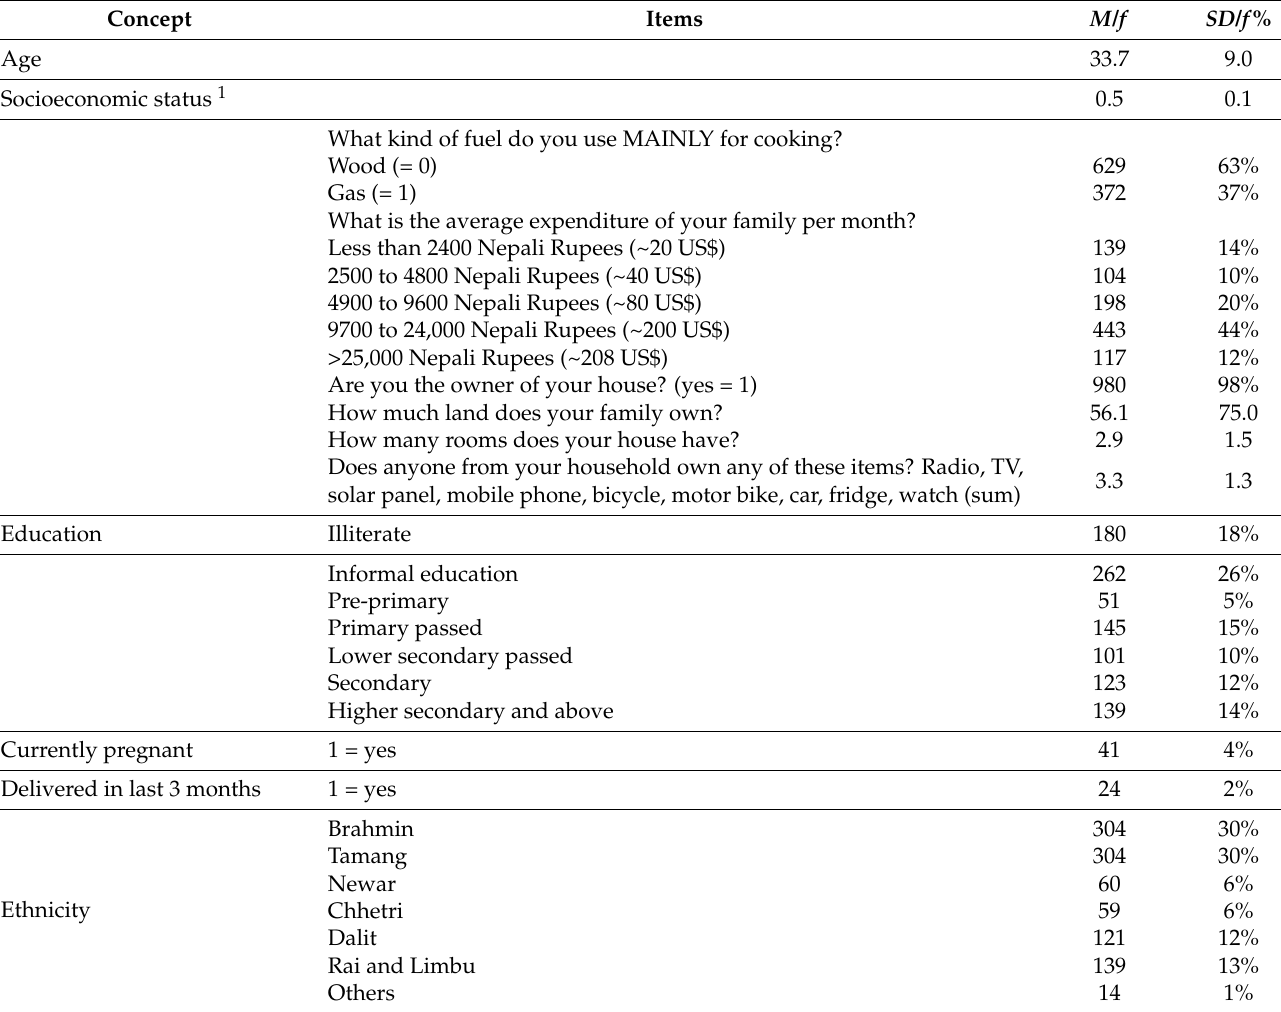
Table 2. Sociodemographic data.